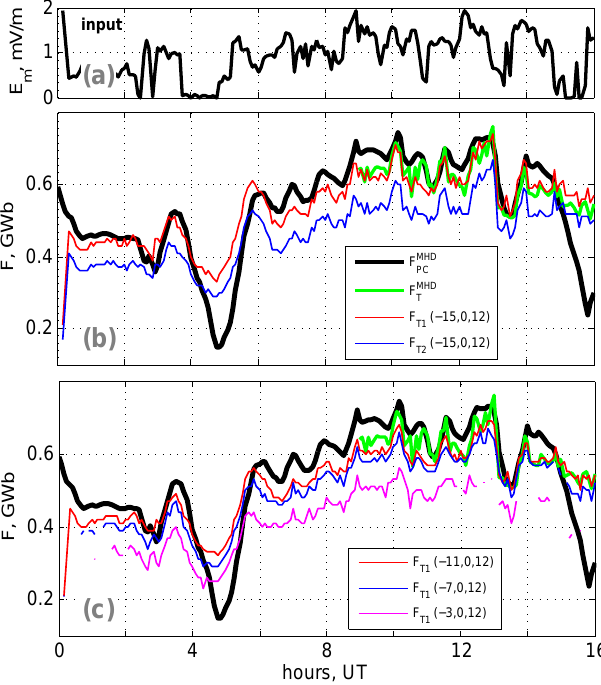
Figure 5. Results of the simulation BATSRUS_Sergeev_060508_1. (a) Solar wind “merging electric field” E m variation. (b) Differ- ent F estimates: F MHD (green), F MHD (black), F T 1 (red) and T PC F T 2 (blue). The F T 1 and F T 2 quantities are calculated for the point ( − 15 , 0 , 12). (c) F T 1 values, calculated at different distances x = − 11 (red), − 7 (blue) and − 3 R E (magenta), compared with F MHD (black) and F MHD T PC